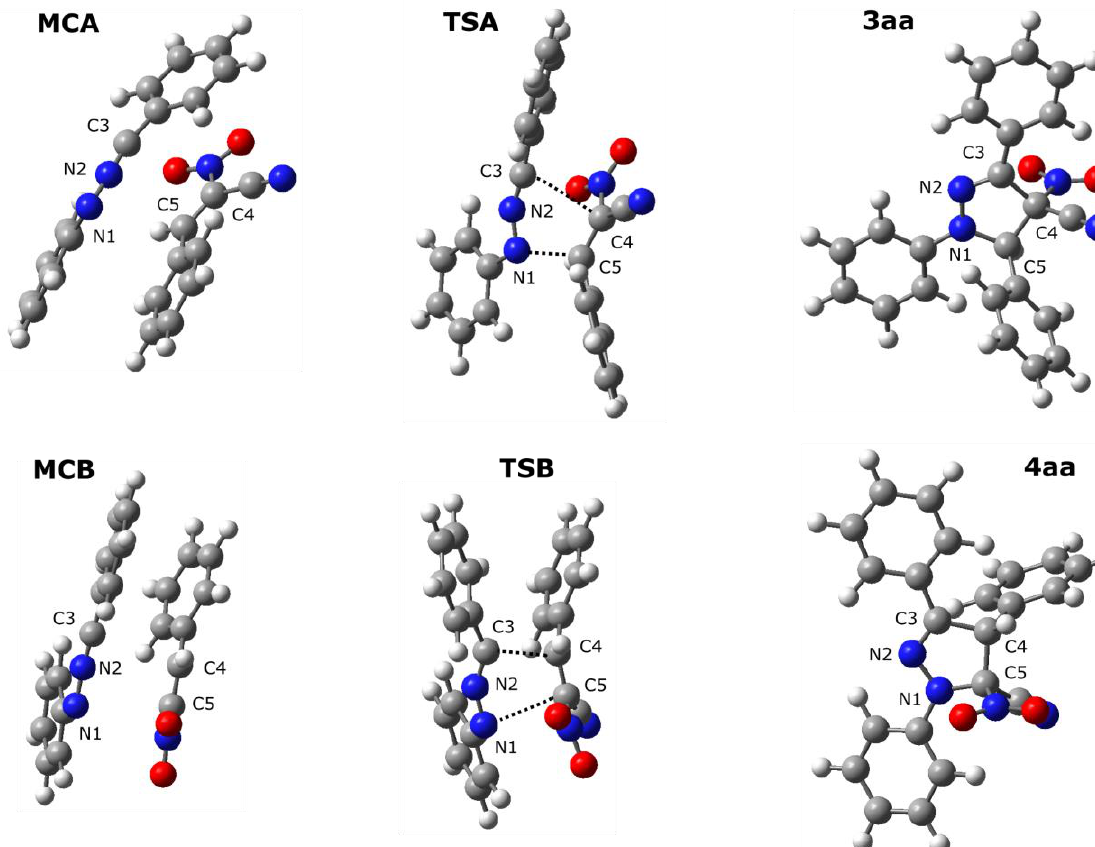
Figure 2. Enthalpy profile for the 32CA between diarylnitrylimine 1a and can 2a in toluene solution according to the DFT computational study. Table 4. Selected parameters for the key structures of the 32CAs of diarylnitrylimines 1a – e and ACNs 2a – c , in toluene, obtained from DFT calculations.